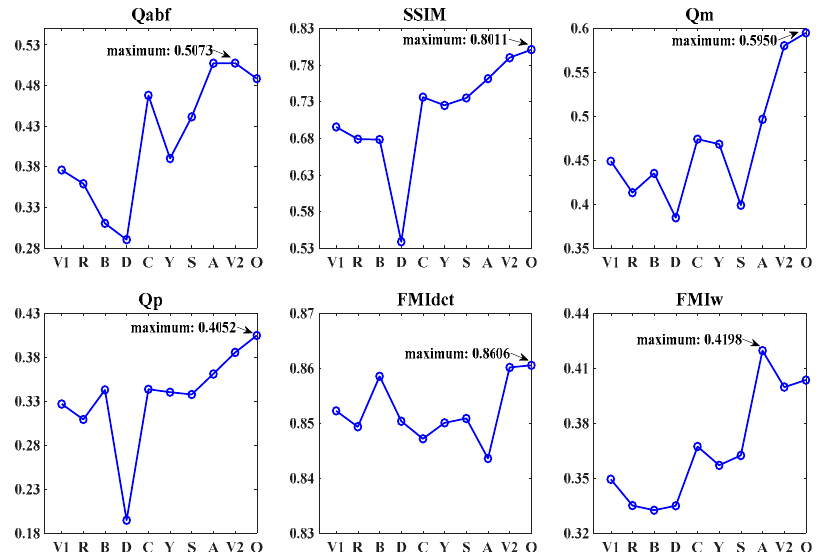
Figure 7. Average values of the six objective indicators for 30 sets of images from the RoadScene dataset. Here, V1, R, B, D, C, Y, S, A, V2, and O denote VggML, Resnet50, BayF, DDcGAN, CSF, YDTR, SeAFusion, AUIF, VEHMD, and Ours, respectively.